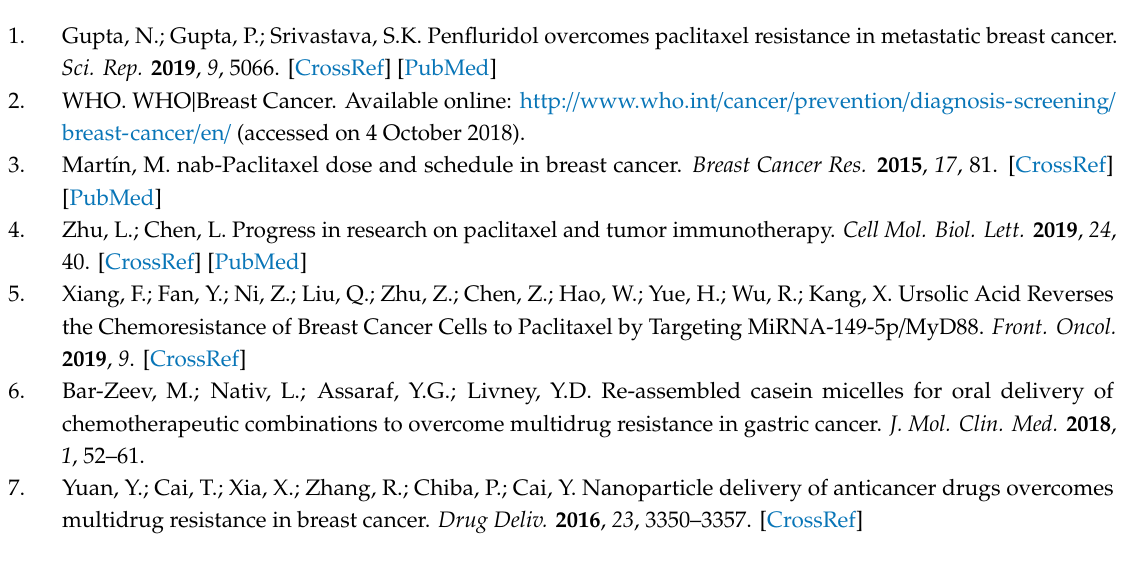
Figure S1: Standard Calibration Curve of PTX following HPLC analysis for free PTX concentration (0–50 uM), using an Agilent HPLC system with L.C. software coupled to a DAD detector and equipped with Column C18 (4.6 × 150 mm, 5 µ m) maintained at 30 ◦ C. Acetonitrile / water (55:45) was used as a mobile phase with a flow rate of 1.5 mL / min and an injection volume of 4 µ L was used throughout. Detection was at 227 nm; Figure S2: EDX analysis (a) SEM image of Blank NaCNs (1 mg / mL) (b) sample elemental distribution in tabular form (c) sample elemental distribution where keV is the accelerating voltage range used for EDX analysis, and cps / eV is counts per sec per electron-volt. (d) SEM images showing the uniform distribution of C, O, Na and Ca elements in the sample at a scale bar of 1 µ m; Figure S3: Graphical representation of Cumulants Analysis and the Multimodel Analysis Parameters produced via a DLS technique for determination of particle size distribution of